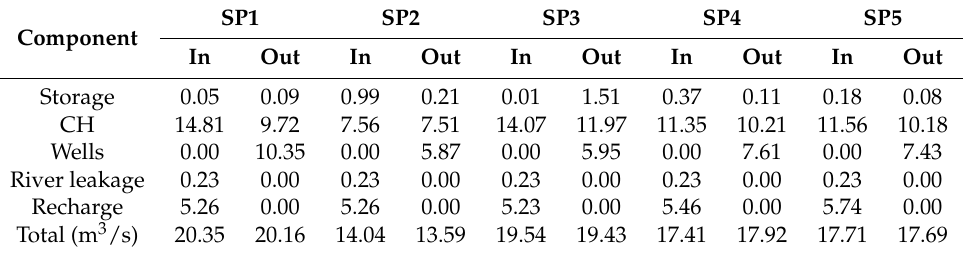
Figure 5. Scaled Root Mean Square Error (RMSE) of each stress period (SP). Table 6. Total water budget (inflow-outflow in m 3 /s) for each stress period (SP).